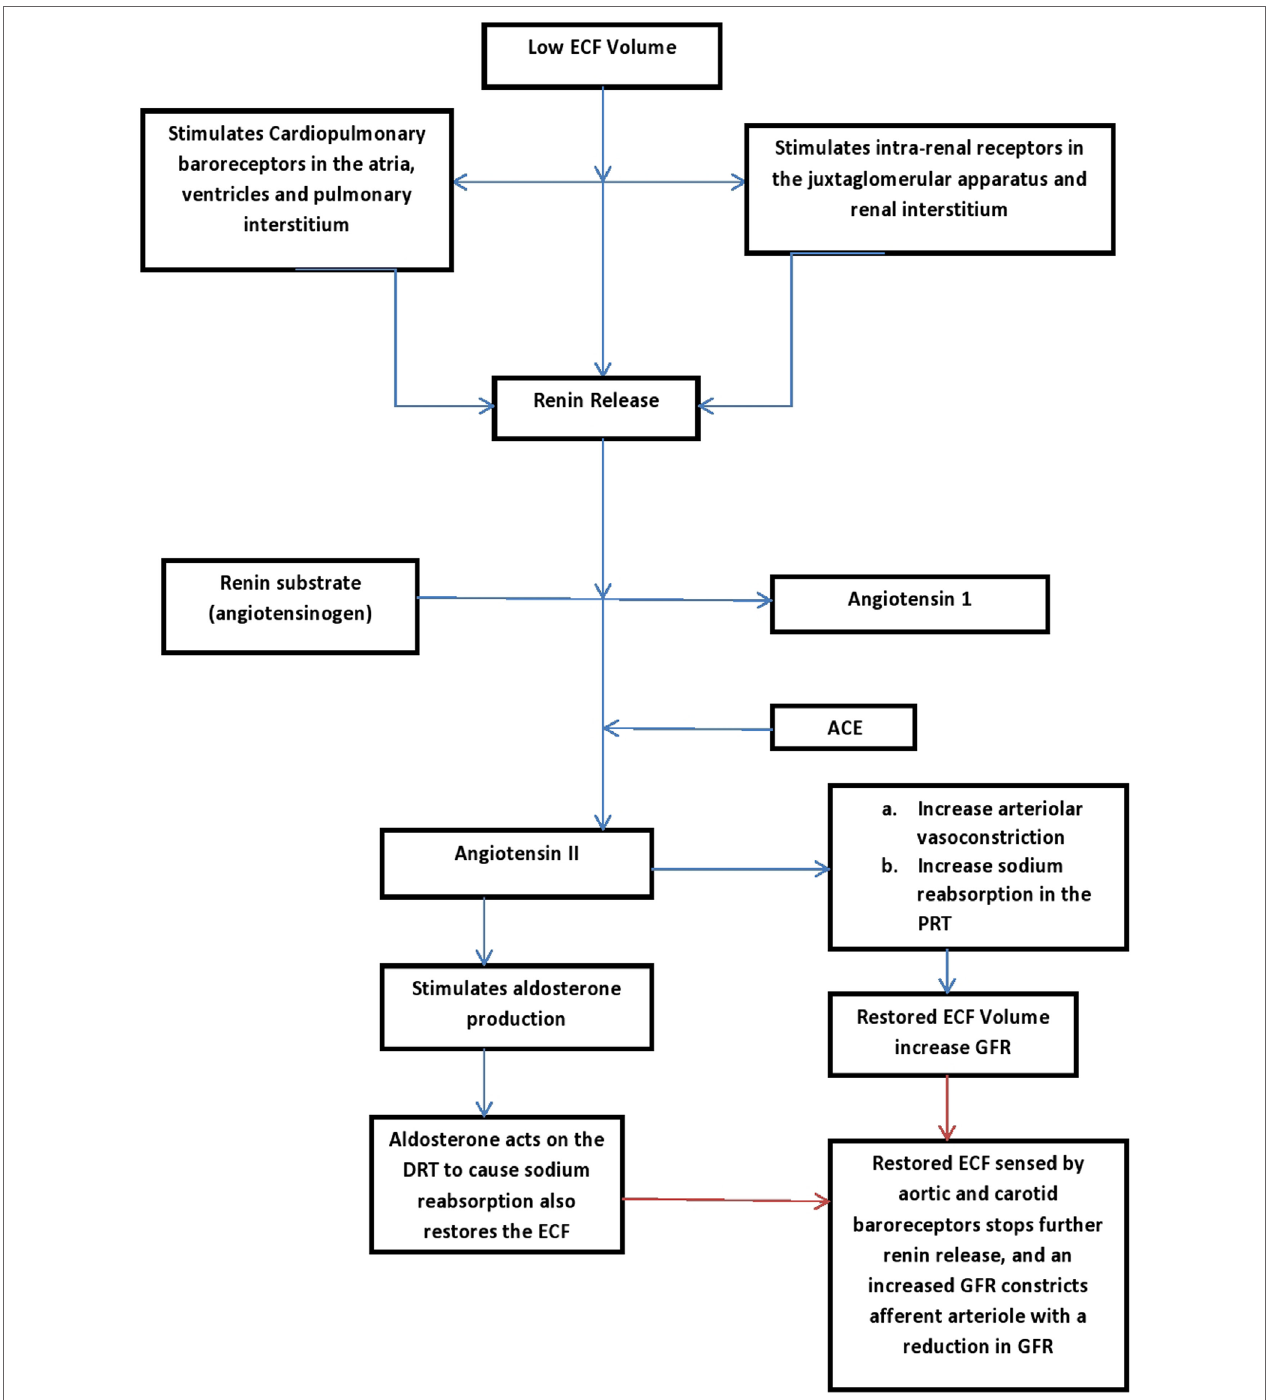
FiGURe 2 | Renin-aldosterone pathways (16, 34). PRT, proximal renal tubles; DRT, distal renal tubles; GFR, glomerular filtration rate; ECF, extracellular